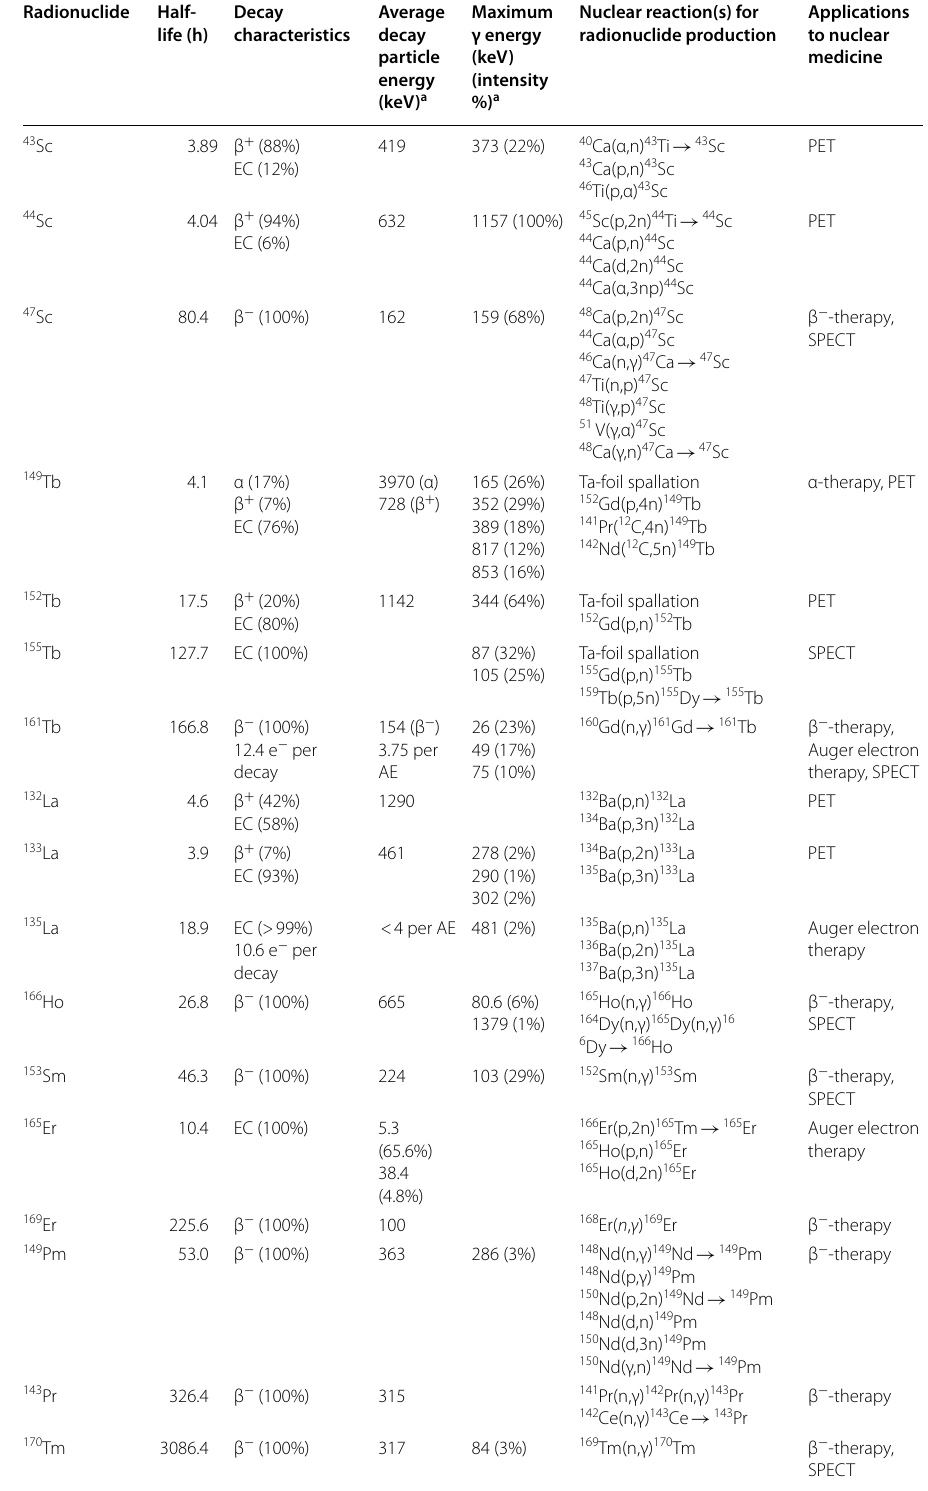
Nuclear reaction(s) for radionuclide production